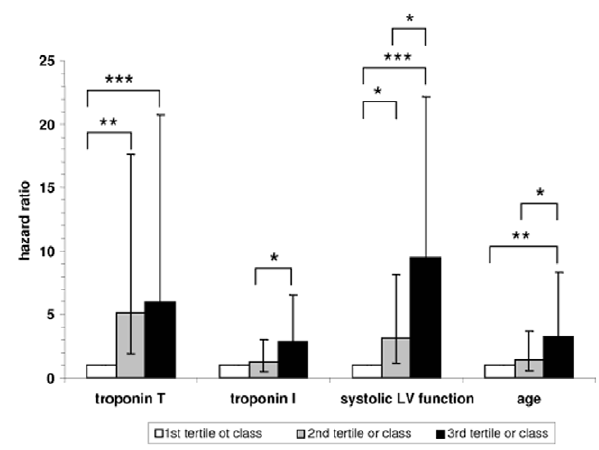
Figure 5. Hazard ratio of mortality according to tertiles of troponin T ( , 37; 38–67; . 67 pg/ml), troponin I ( , 10; 10–22; . 22 pg/ml), age ( , 63; 63–75; . 75 years) and classes of systolic LV function (1=normal, 2=mildly reduced; 3=moder- ately and severe reduced). Error bars represent lower and upper 95% confidence interval. The hazard ratio of the first tertile or class, respectively, was set to 1. ** p , 0.01, *** p , 0.001.